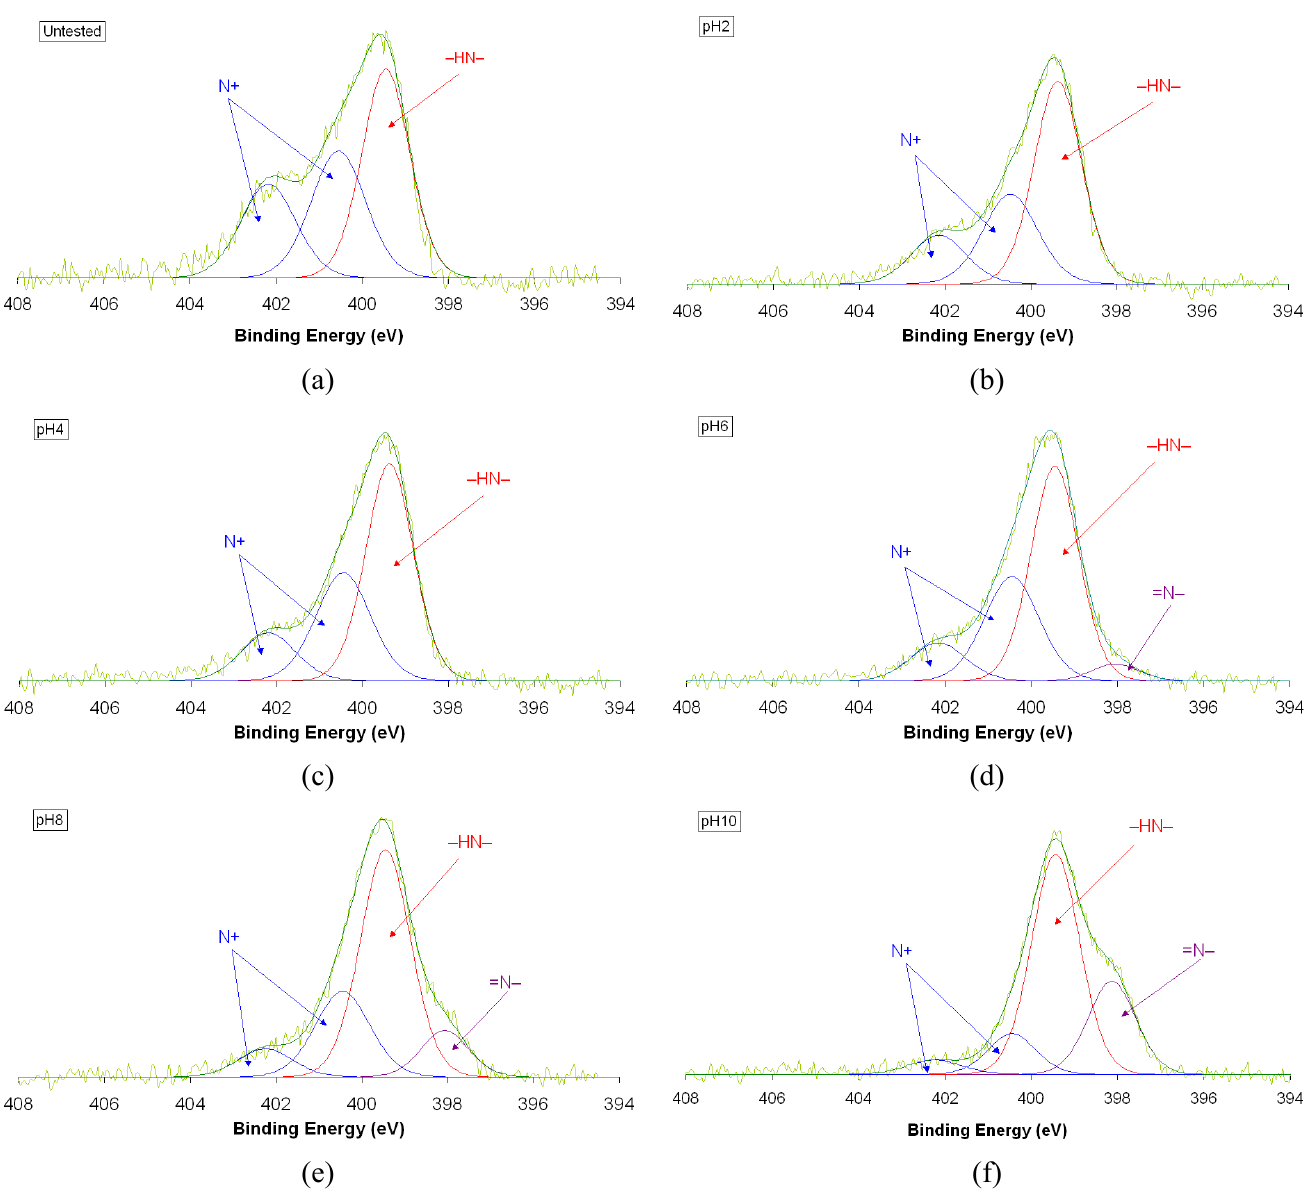
Figure 7. XPS spectra (N 1s) of 120 µm PANI composite thick films tested over 96 hours showing: (a) untested film; (b) film soaked in pH2 buffer; (c) film soaked in pH4 buffer; (d) film soaked in pH6 buffer; (e) film soaked in pH8 buffer; and (f) film soaked in pH10